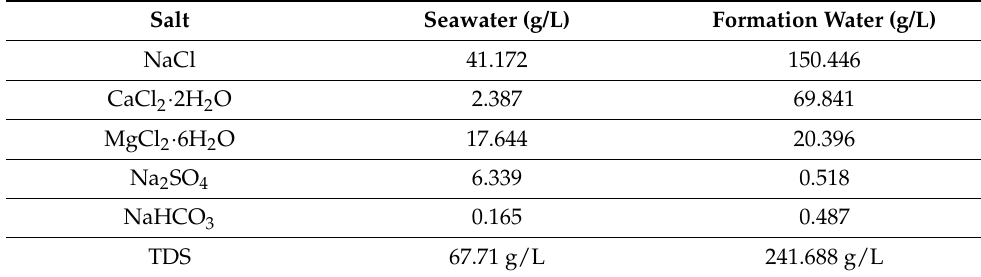
Table 1. Composition of seawater and formation